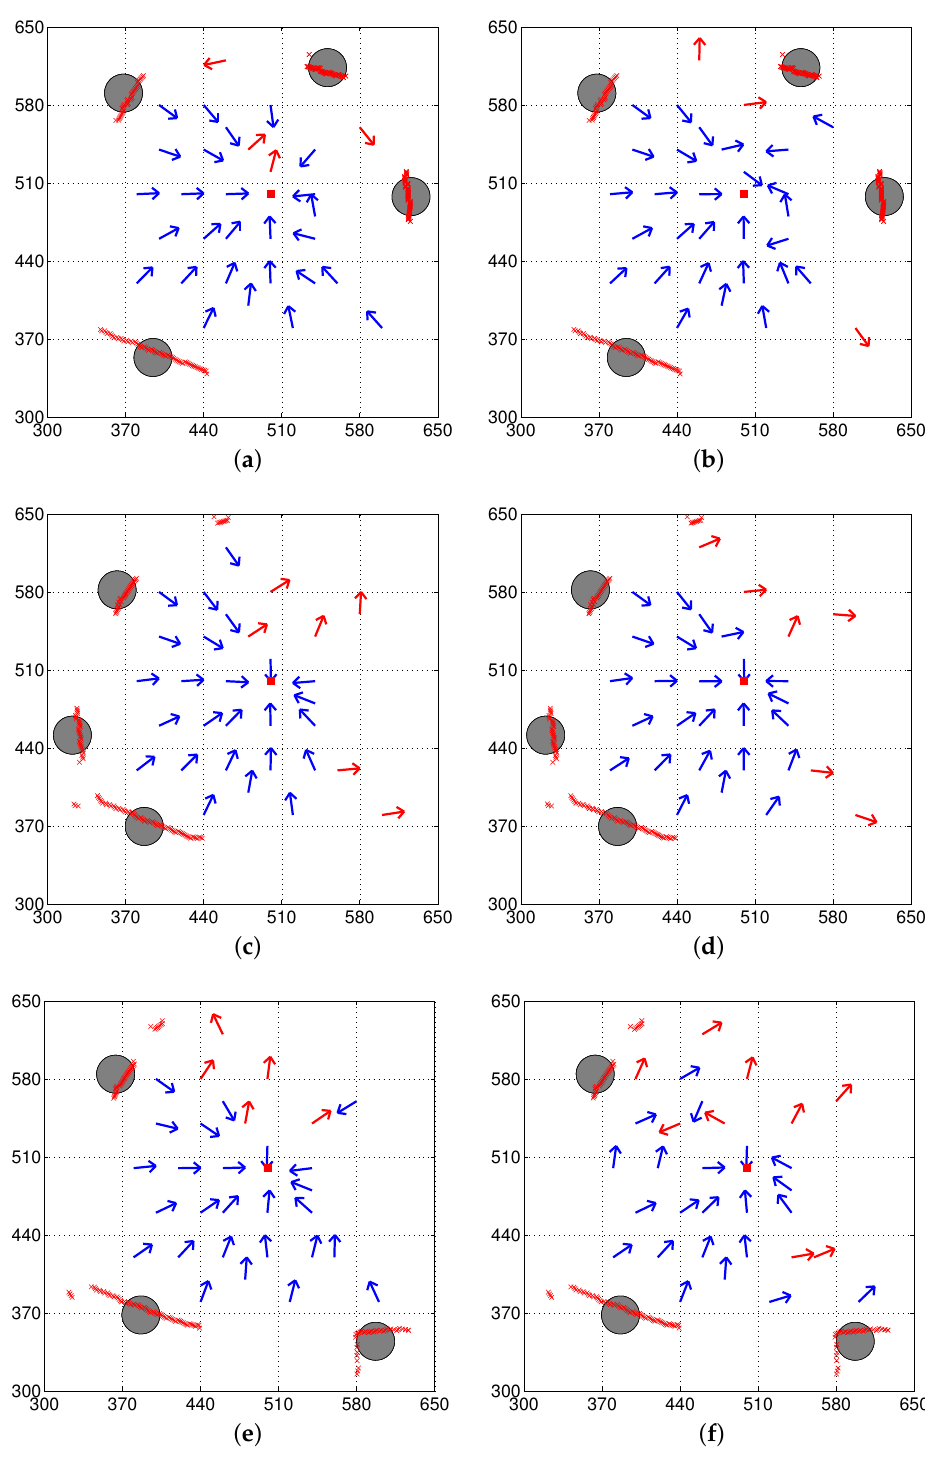
Figure 6. Vector map results with the DELV method (from the omni-directional depth snapshot, left column: with reference compass, right column: without reference compass); ( a , b ) env1; ( c , d ) env2; ( e , f ) env3 (blue and red arrows indicate small and large homing errors, respectively, and circles represent close landmark objects obtained after